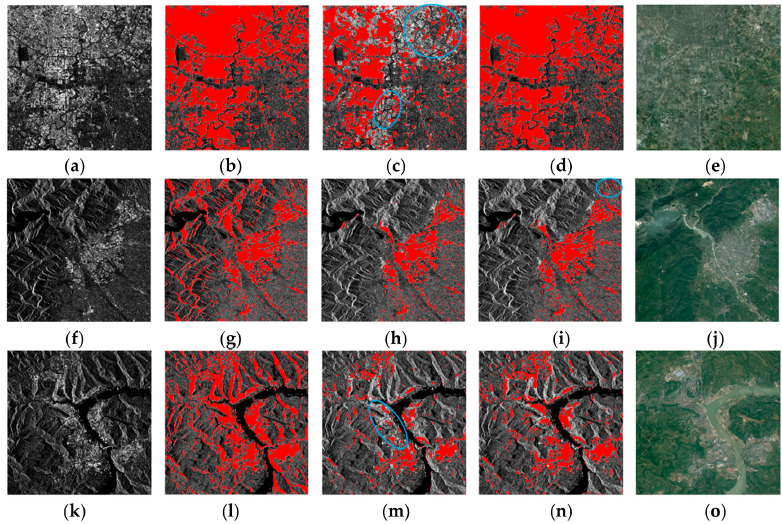
Figure 6. Mountain masking results based on two kinds of DEM products. SAR images of three subset areas in the first column ( a , f , k ); corresponding BAs without mountain masking in the second column ( b , g , l ); BAs with mountain masking using ASTER GDEM2 in the third column ( c , h , m ); BAs with mountain masking using SRTM DEM in the fourth column ( d , i , n ); corresponding optical images from Google Earth maps in the fifth column ( e , j , o ). Red: